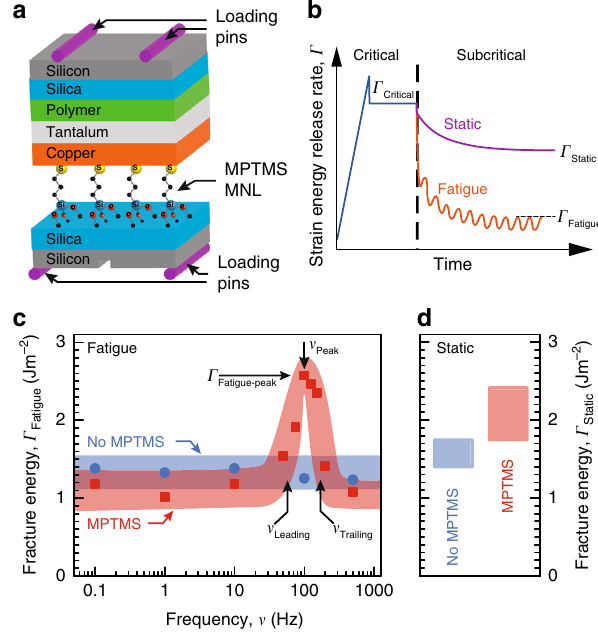
Fig. 1 Fracture energy of epoxy-Cu-MPTMS-SiO 2 structures under static and fatigue loading. a Schematic depicting the four-point bending test and b the strain energy release rate characteristics for load-shedding fatigue and static loading. c Fatigue fracture energy of polymer-metal-ceramic structures with Cu-MPTMS-SiO 2 interfaces (red squares) and Cu-SiO 2 = 0.6 kPa, shown together with interfaces (blue circles) determined at p H 2 O d the corresponding static stress fracture energies. Each data point represents at least three tests. The width of the bands, drawn through the data points to guide the eye, connote the experimental